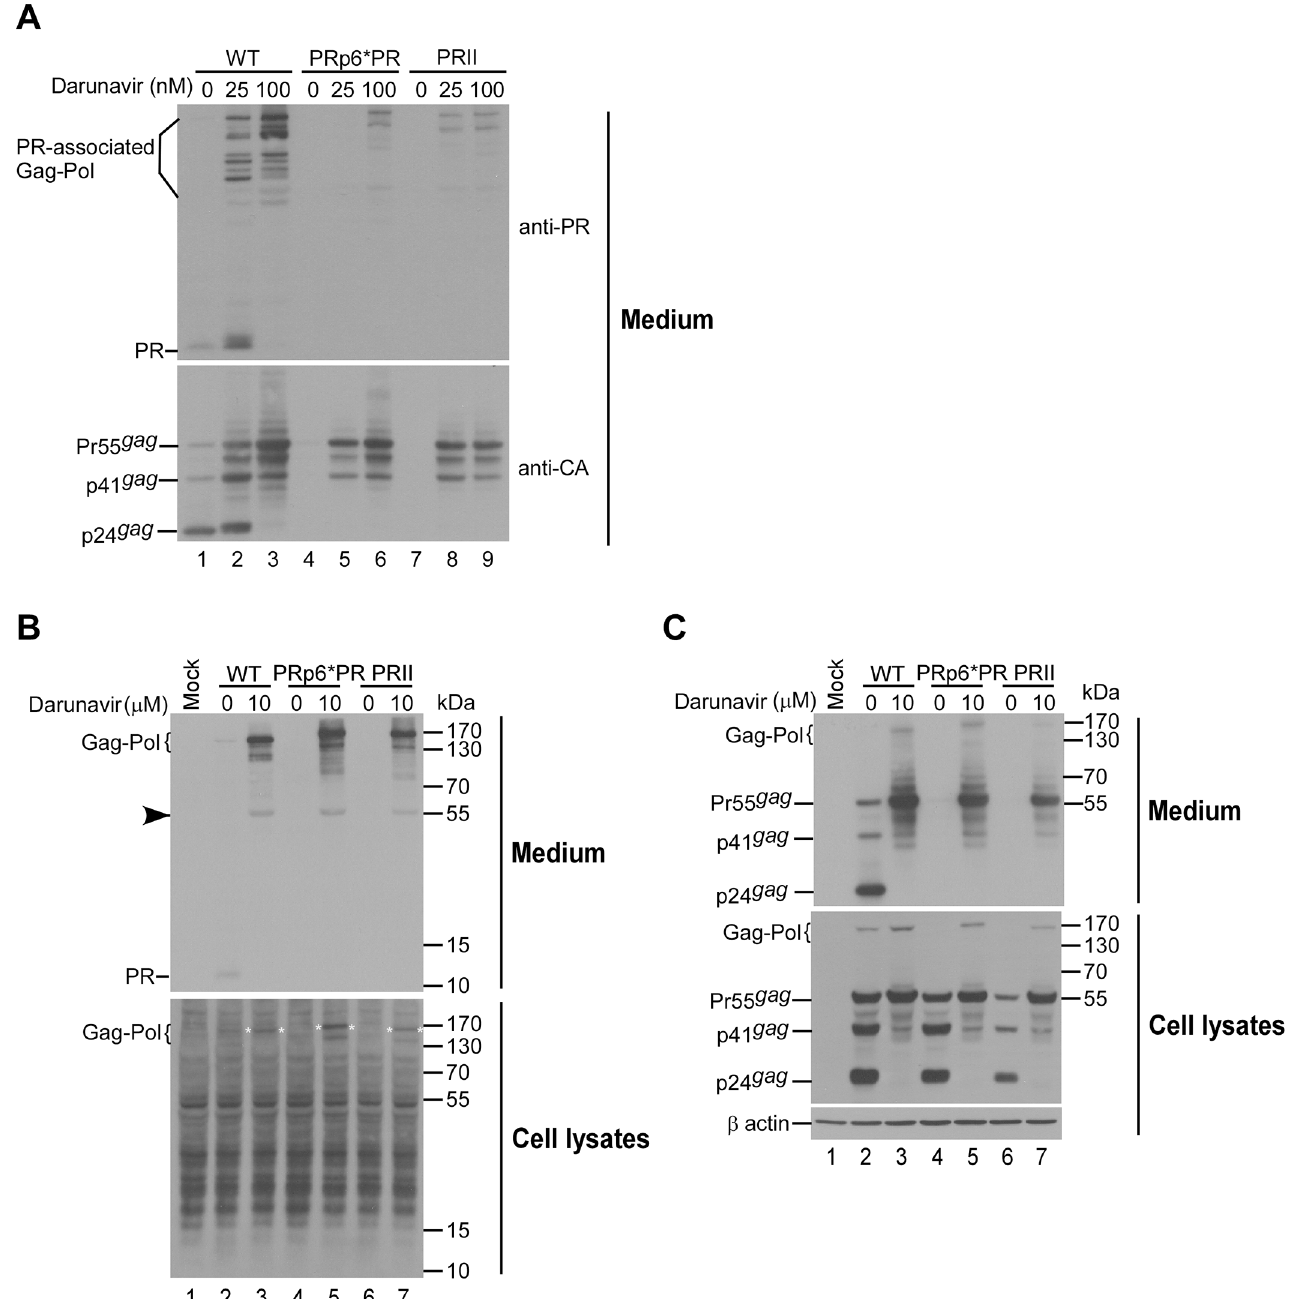
Fig 2. Incorporation of PR and PR-associated Gag-Pol into virus particles. 293T cells were transfected with 10 μ g of designated constructs. At 4 h post- transfection, equal amounts of cells were placed on three (panel A) or two (panel B) dish plates, and either left untreated or treated with darunavier at the indicated concentrations. At 48 h post-transfection, cells and supernatants were collected and subjected to Western immunoblotting. PR and PR-associated Gag-Pol were probed with an anti-PR serum (upper panels A and B). Faint bands corresponding to Pr55 gag likely indicate partial cross-reaction with anti-PR serum (panel B, arrowhead). Membranes were stripped and reprobed with an anti-p24CA monoclonal antibody. Panels B and C are derived from the same blot. Positions of molecular size markers and HIV-1 Gag proteins Pr55, p41 and p24, and PR-associated Gag-Pol proteins are